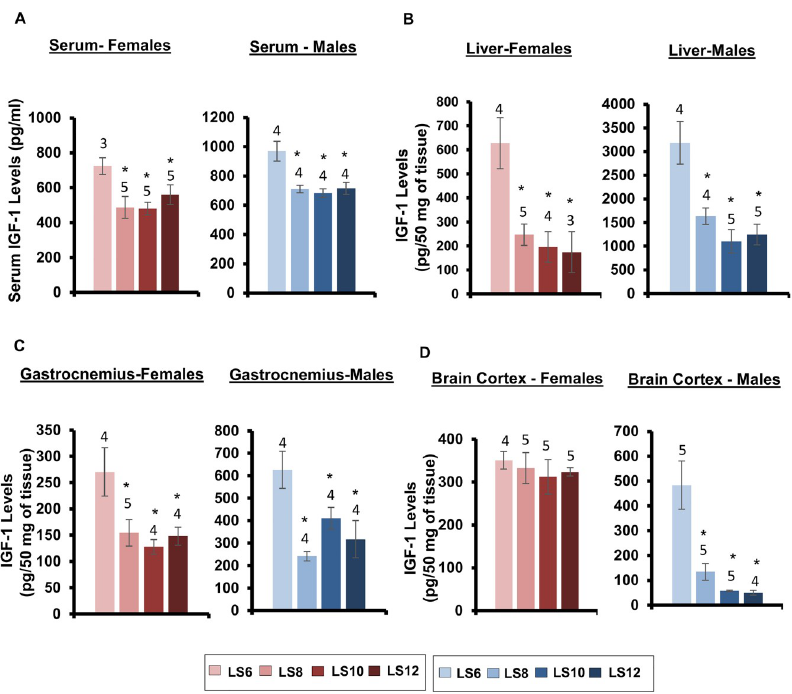
Fig 6. Effect of litter expansion on IGF-1 levels. The protein levels of IGF-1 protein were measured in serum (A), liver (B), gastrocnemius (C), and cortex (D) of 15-month-old male and female mice as described in the Methods. Data represented are the mean ± SEM from 3–5 mice per group. All groups were compared to control LS6 and were statistically analyzed by one-way ANOVA with Tukey’s and FDR with Benjamini & Hochberg multiple correction test ( � p <